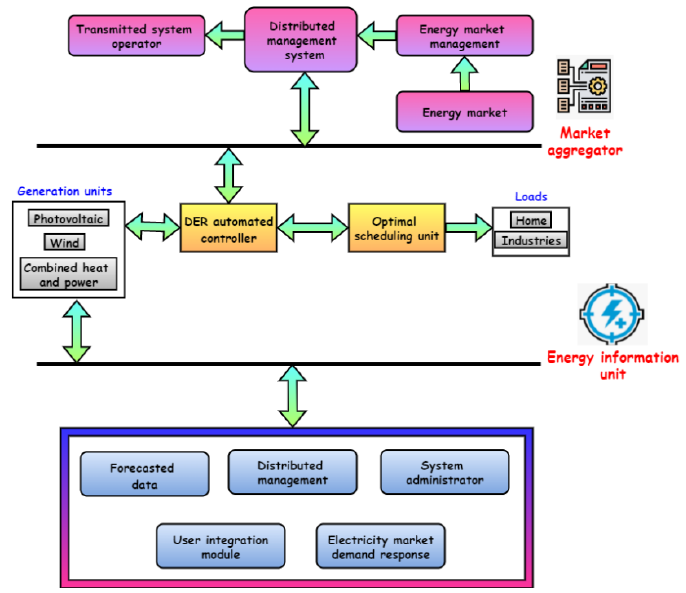
Figure 5. Integrating demand-side management while operating a VPP.